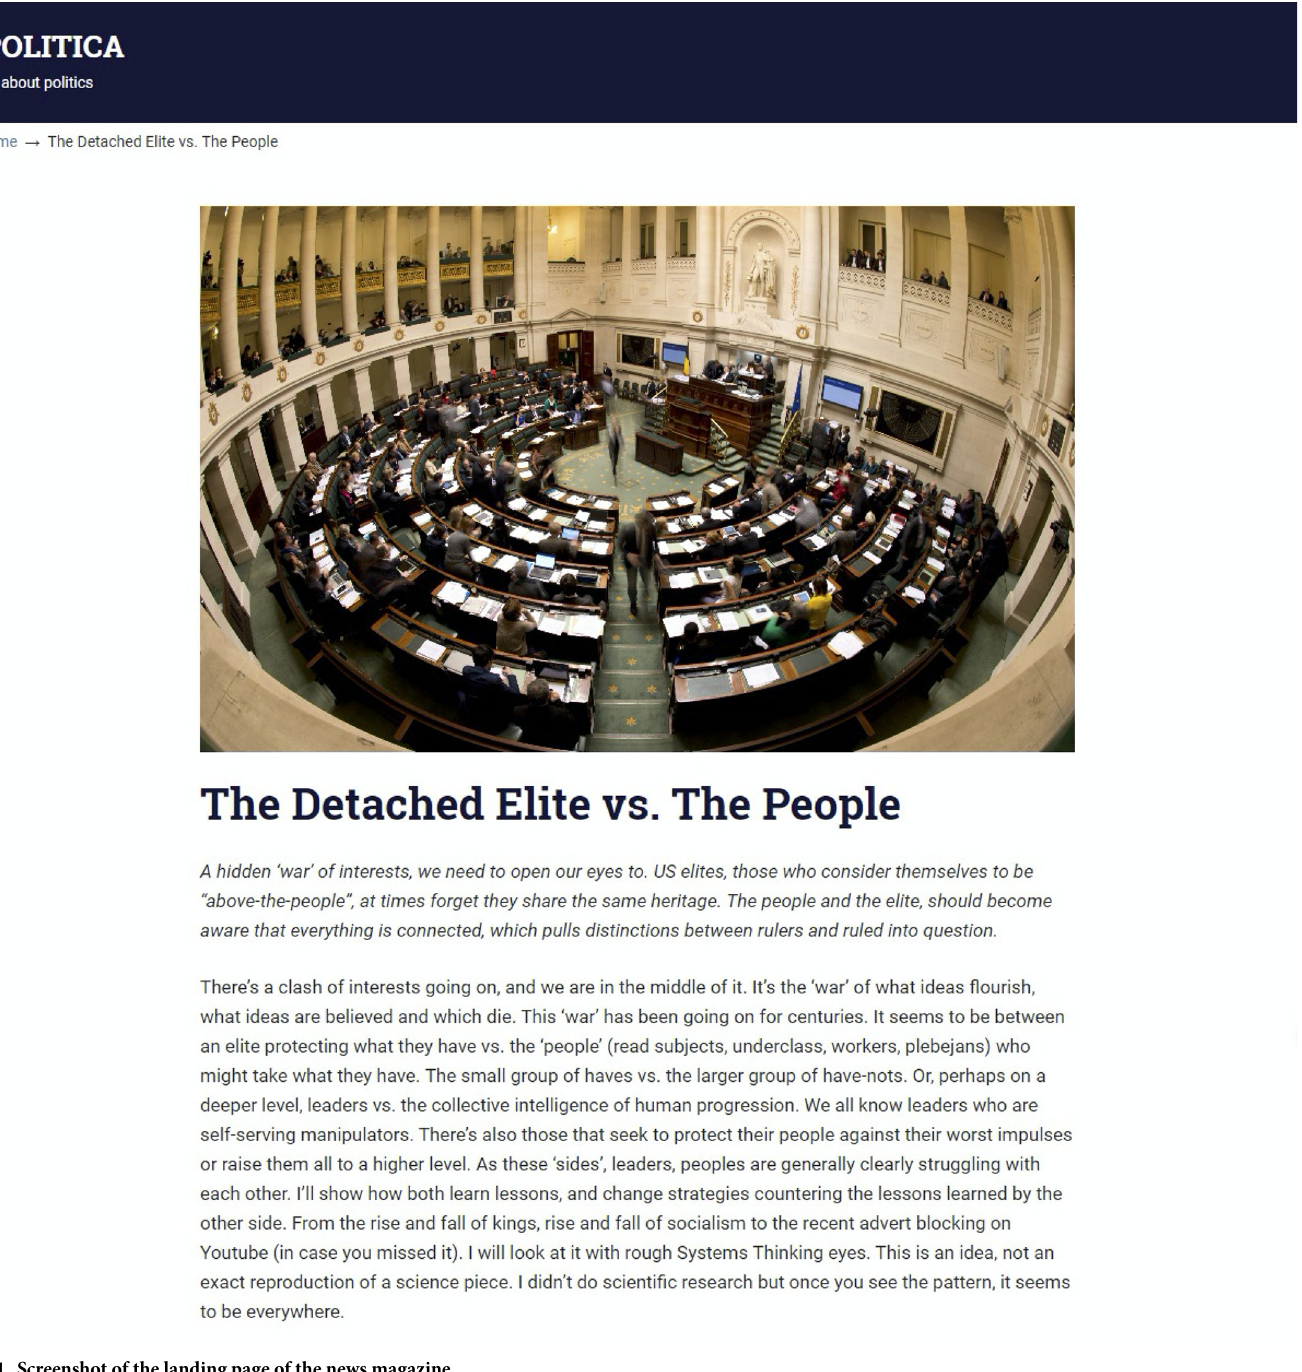
Fig 1. Screenshot of the landing page of the news